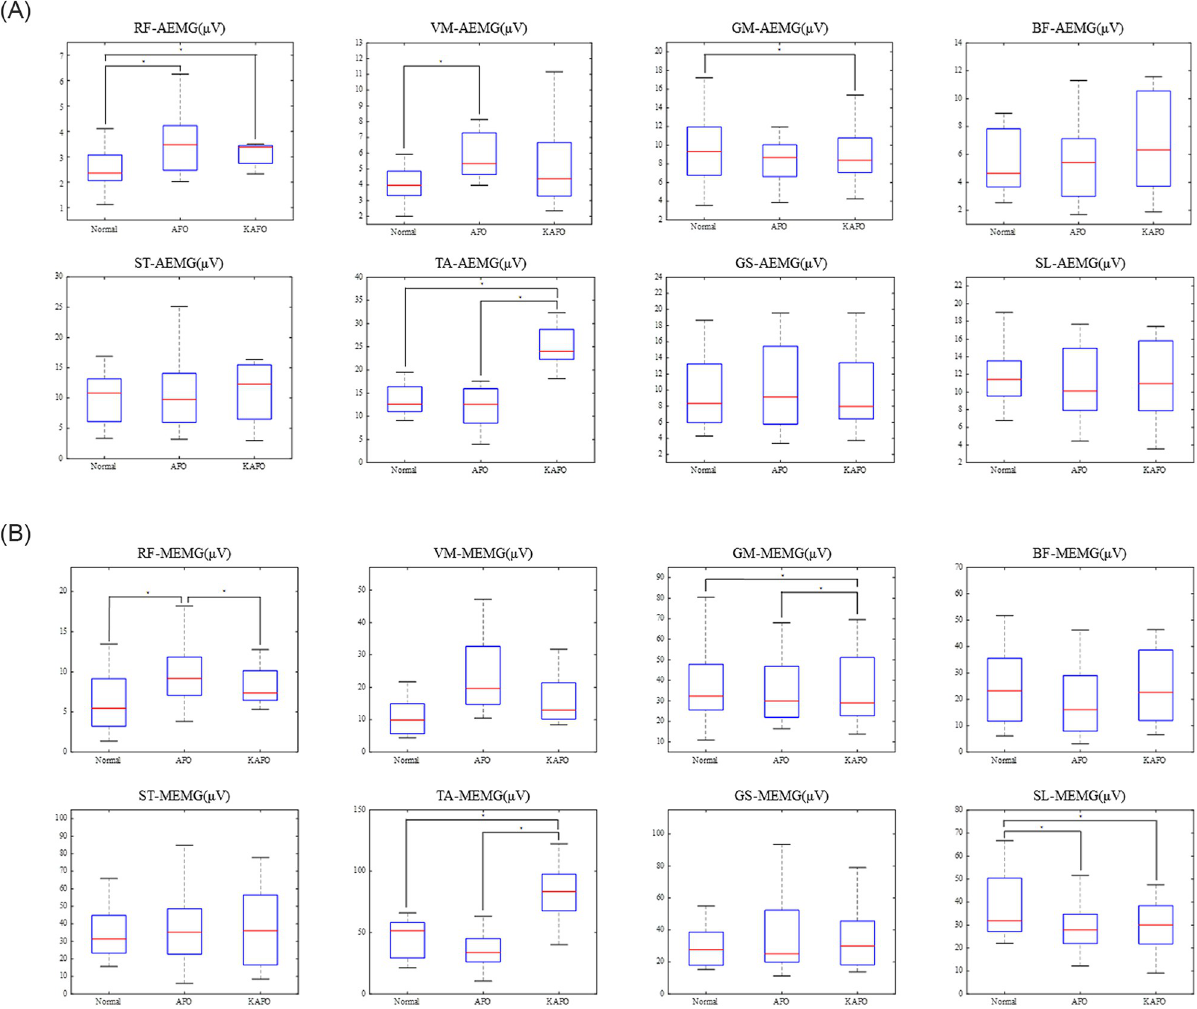
Fig 2. Results of the AEMG (2A) and MEMG (2B) of each muscle. Asterisks represent significant differences (p < 0.05) between each condition revealed by post hoc